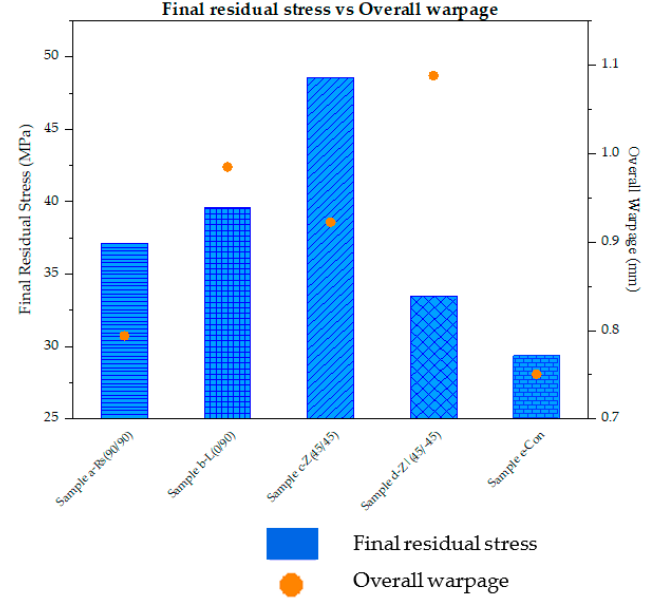
Figure 9. Comparison of final residual stress and overall warpage results from element m of sample a-Rs (90°/90°), b-L (0°/90°), c-Z (45°/45°), d-Z (45°/ − 45°), and e-Con.